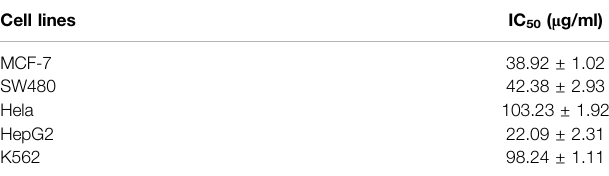
TABLE 1 | Cell viability of HWE on human cancer